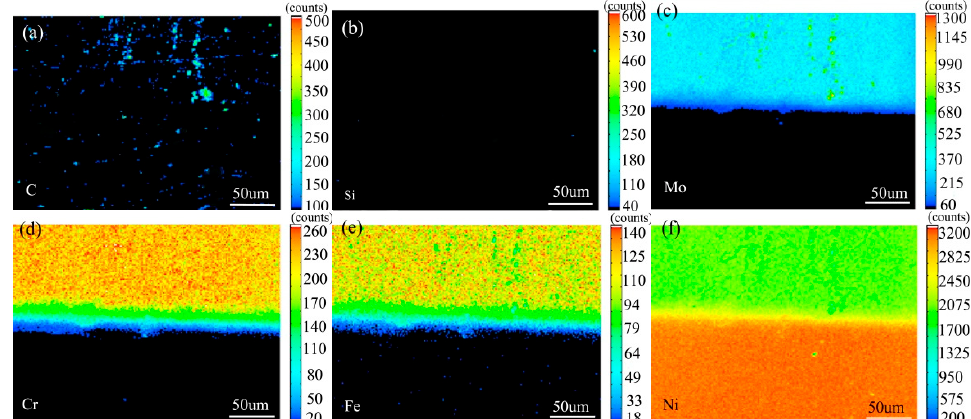
Figure 7. Composition distribution map of the diffusion couple sample of 0Si alloy and pure nickel after 800 °C/200 h heat treatment: ( a ) C, ( b ) Si, ( c ) Mo, ( d ) Cr, ( e ) Fe, and ( f ) Ni.